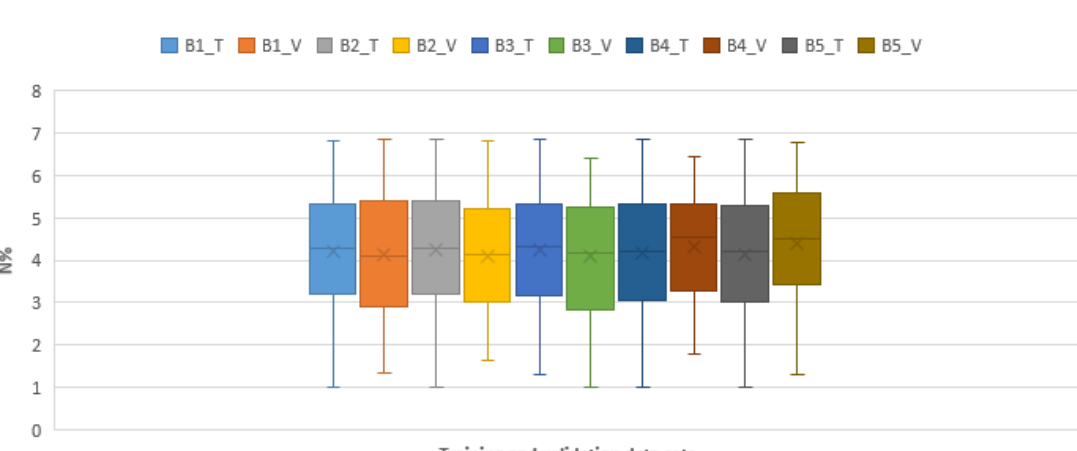
Figure A3. Distributions of reference N% values ( a ) Distribution of all N% values. The mean N value is 4.22% with a standard deviation of 1.31%. The distribution has the highest peak in the range of 5.5% to 6.0%. ( b ) Box & whisker plot of the N% values according to the plants and N treatments.